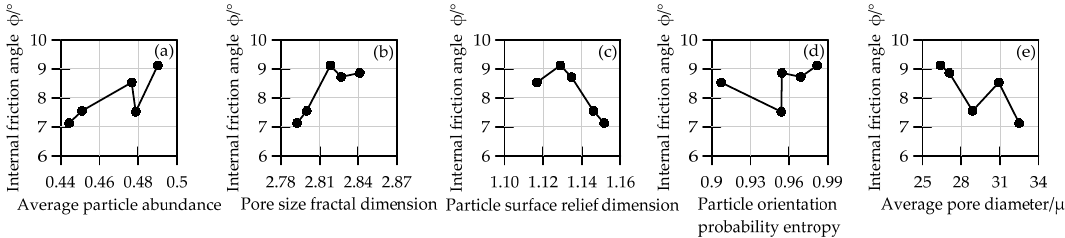
Figure 15. The curve of the internal friction angle of S0 versus the five most relevant microscopic parameters after F-T cycles: (a) C, (b) D hs , (c) D pr , (d) H m , and (e) D h.